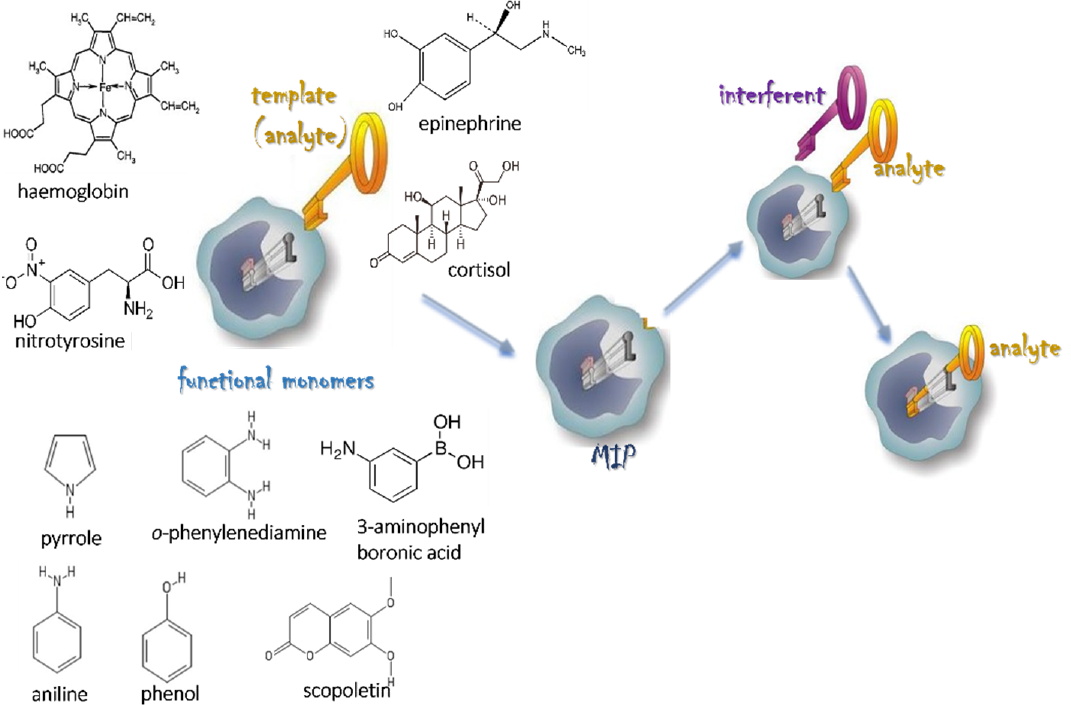
Figure 1. Theory behind the molecular imprinting: a pre-polymer solution containing a template (usually the analyte) and a polymerizable functional monomer is required. Under suitable conditions, many monomers surrounding the analyte transform into an artificial coating with the trapped analyte. After removing the template (analyte), specific cavities remain in the polymer matrix, and the size and chemical interactions complement the analyte molecule. During incubation with the analyte in the sample, the analyte binds specifically to the formed MIP (like the “lock and key” analogy). The figure shows the functional monomers most commonly used for electrosynthetic MIP in combination with some corresponding target analytes. The figure was prepared based on the information provided in the text of [4].